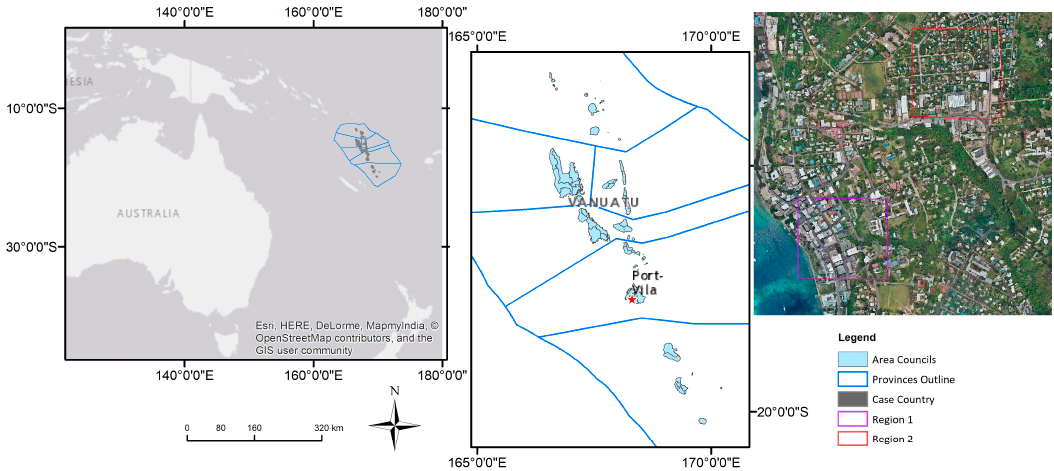
Figure 1. The reference map of study area, with the left map describes the location of Vanuatu in the world, and the middle map presents the territory of Vanuatu, while the right map illustrates the two selected regions in Port Vila.